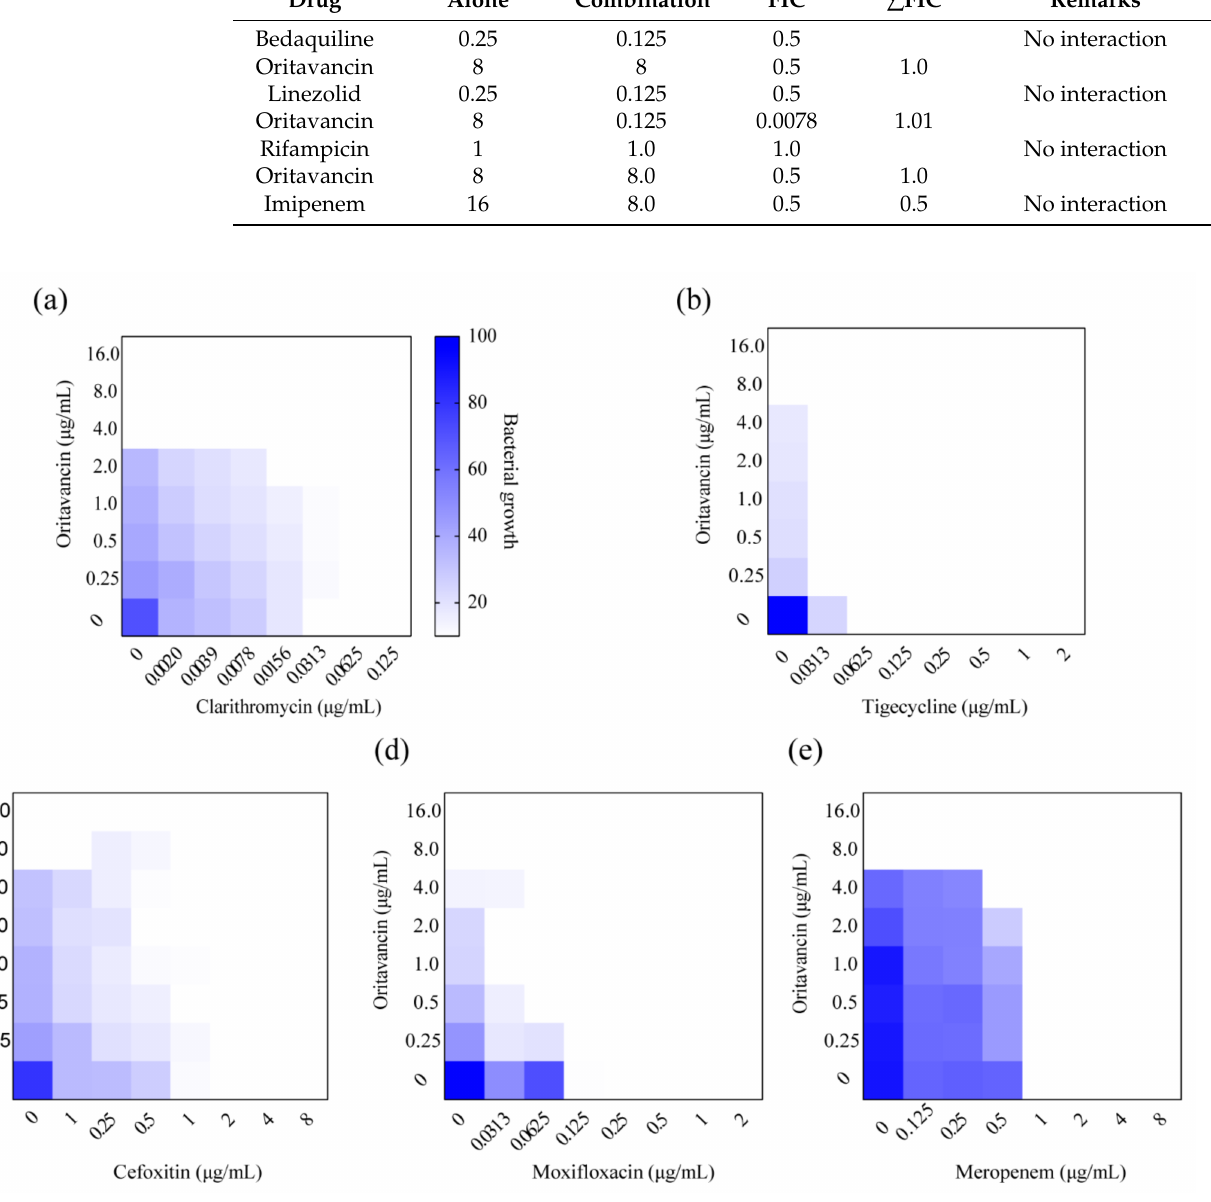
Figure 3. Synergism of oritavancin with ( a ) clarithromycin, ( b ) tigecycline, ( c ) cefoxitin, ( d ) moxifloxacin, and ( e ) meropenem against M. abscessus . Dark blue regions indicate high bacterial growth with low inhibition rate. The MICs of oritavancin, clarithromycin, tigecycline, cefoxitin, moxifloxacin, and meropenem against M. abscessus were 8.0 µ g/mL, 0.0625 µ g/mL, 1.0 µ g/mL, 4.0 µ g/mL, 1.0 µ g/mL, and 4.0 µ g/mL, respectively. Data are expressed as the mean OD 600 of two biological replicates. The FICI ≤ 0.05 is defined as